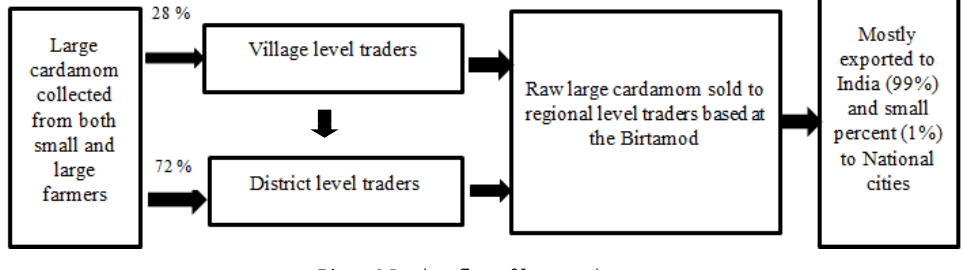
Figure 2 Product flow of large cardamom